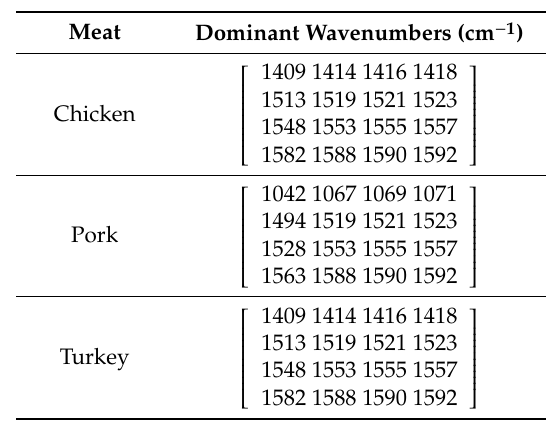
Figure 9. FACS graph of meat spectrum at 1600–1000 cm −1 region.